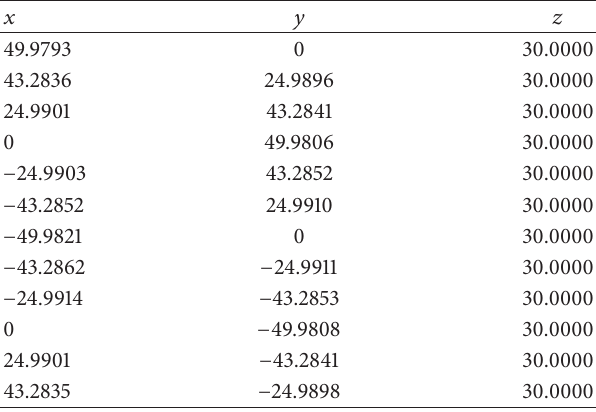
Table 1: Measuring points on section 1 (/mm).